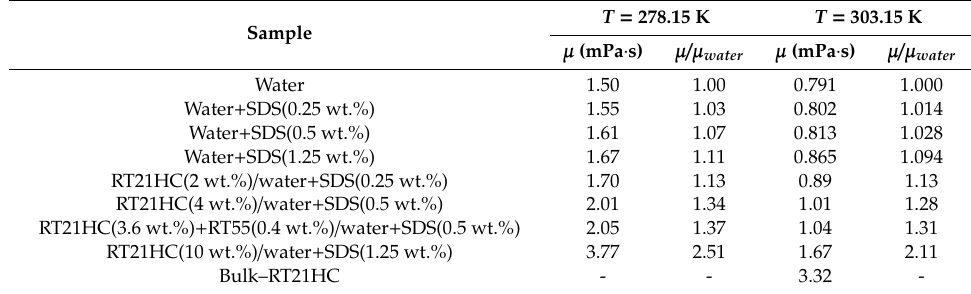
Table 1. Dynamic viscosities, µ , and viscosity increases regarding to water, µ / µ water , obtained for the di ff erent samples at ~100 s − 1